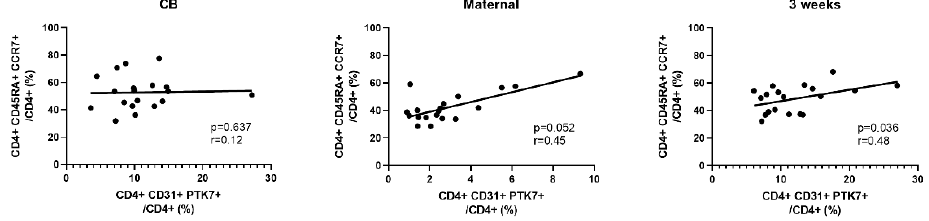
Figure 4. Spearman’s correlations of the proportion of recent thymic emigrants (RTE, horizontal axis) and naïve CD4 cells (vertical axis) in cord blood (CB), maternal blood, and neonatal blood at three weeks of age ( n = 19 in each group).